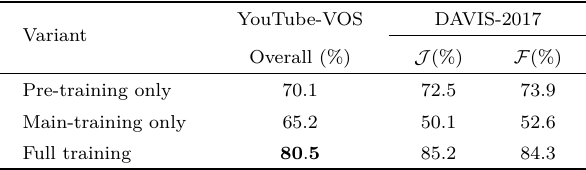
Table 1 Comparison of accuracy of model with full training to models using pre-training only or main training only